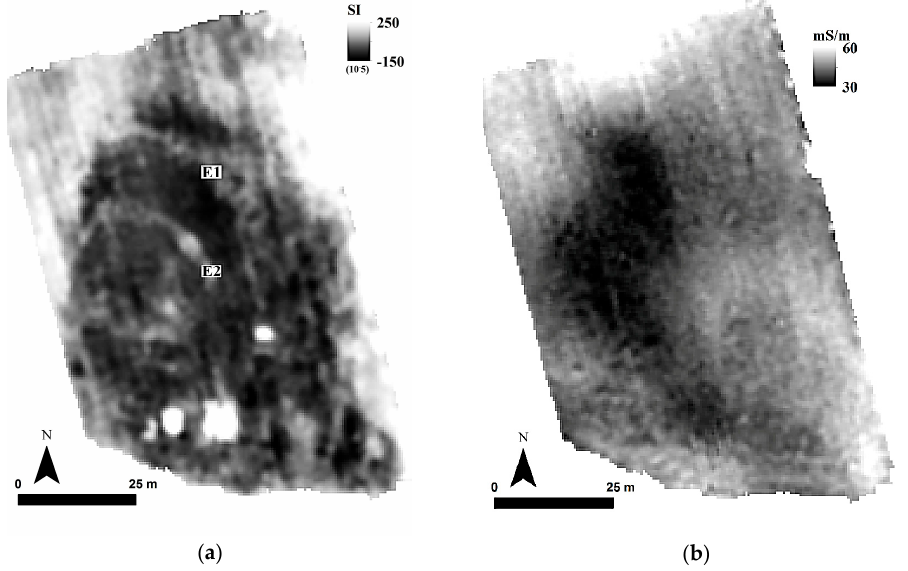
Figure 21. Magnetic susceptibility ( a ); and electromagnetic conductivity ( b ) results from Perivlepto/Kastraki 2.